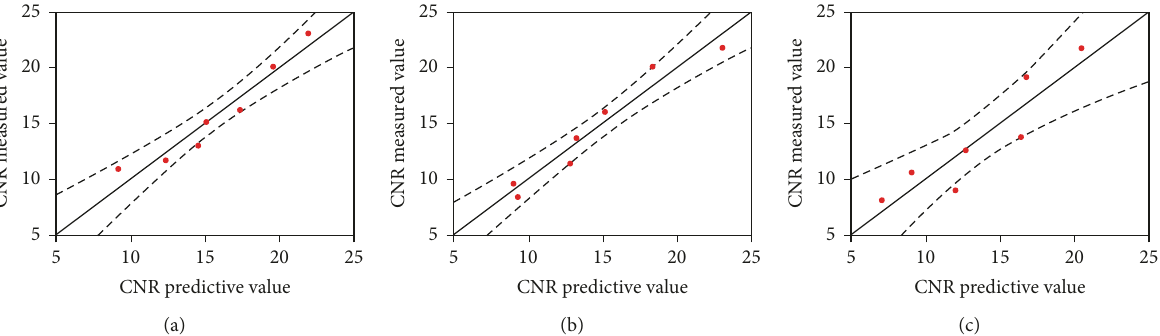
Figure 5: Correlation between the CNR predicted value measured at different tissue ratios in (a) model A (30/70), (b) model B (50/50), and (c) model C (70/30). CNR: contrast to noise ratio. ∗ Range above and below the approximate line is 95%